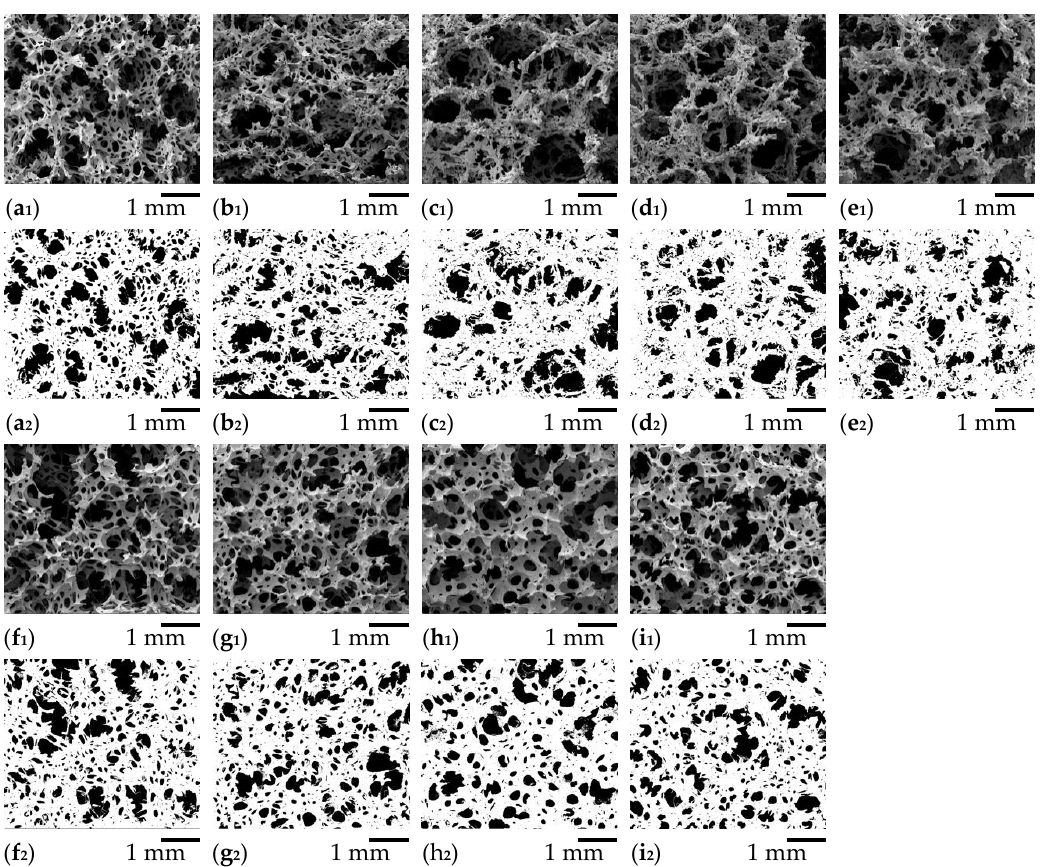
Figure 6. SEM images of: ( a1 ) control NRF; ( b1 ) NRF/2 Ch; ( c1 ) NRF/4 Ch; ( d1 ) NRF/6 Ch; ( e1 ) NRF/8